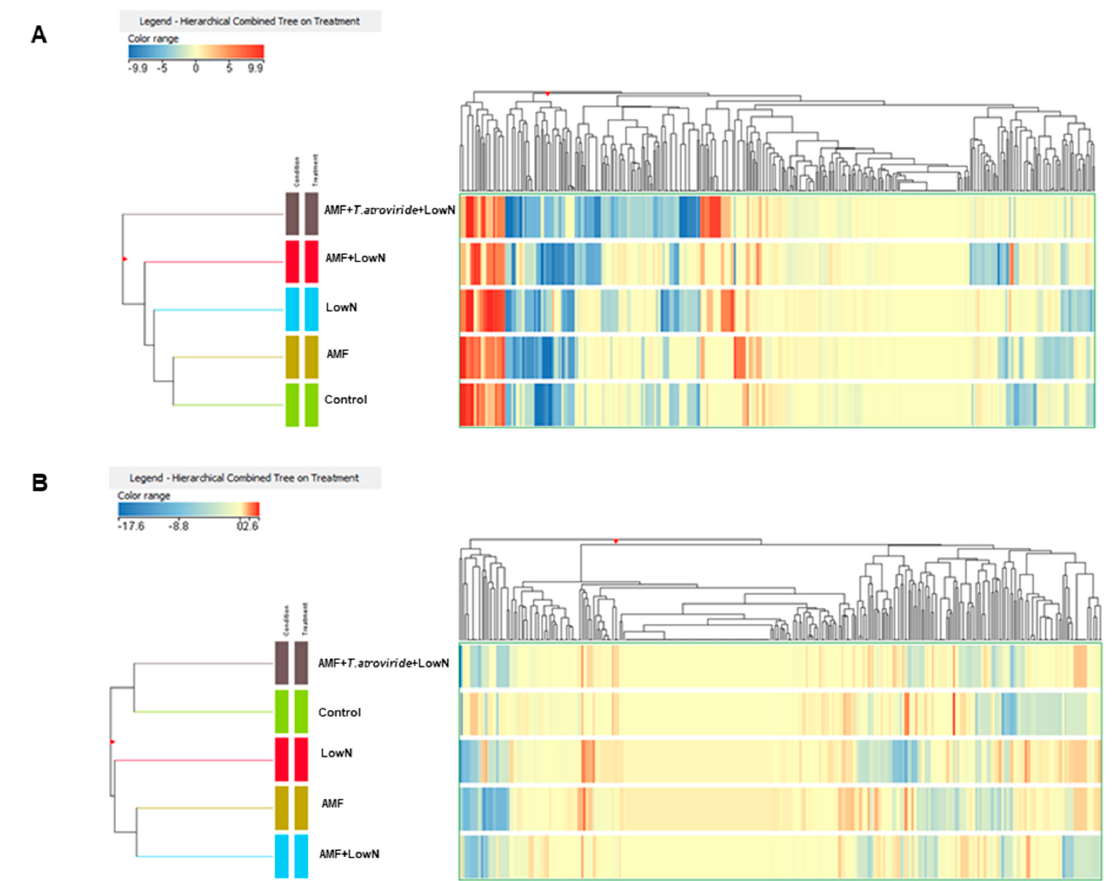
Figure 2. Unsupervised hierarchical cluster analysis (Euclidean distance; linkage rule: Ward) of sub-optimal fertility ( A ) and optimal fertility ( B ) tomato fruits phenolic profiles under LowN, AMF, AMF + LowN, AMF + T. atroviride + Low N and Control conditions. Metabolites were obtained by UHPLC − ESI/QTOF − MS untargeted analysis, and their intensities were used to create the fold − change heatmap provided here. Table 8. Semi-quantitative content of different phenolic classes in tomato fruits from plants grown under low nitrogen fertilization regimen, treated with different biostimulants at the site with optimal soil fertility. The data are presented as cumulate abundance of individual compounds gained from untargeted metabolomics profiling and were elaborated by one-way analysis and Duncan